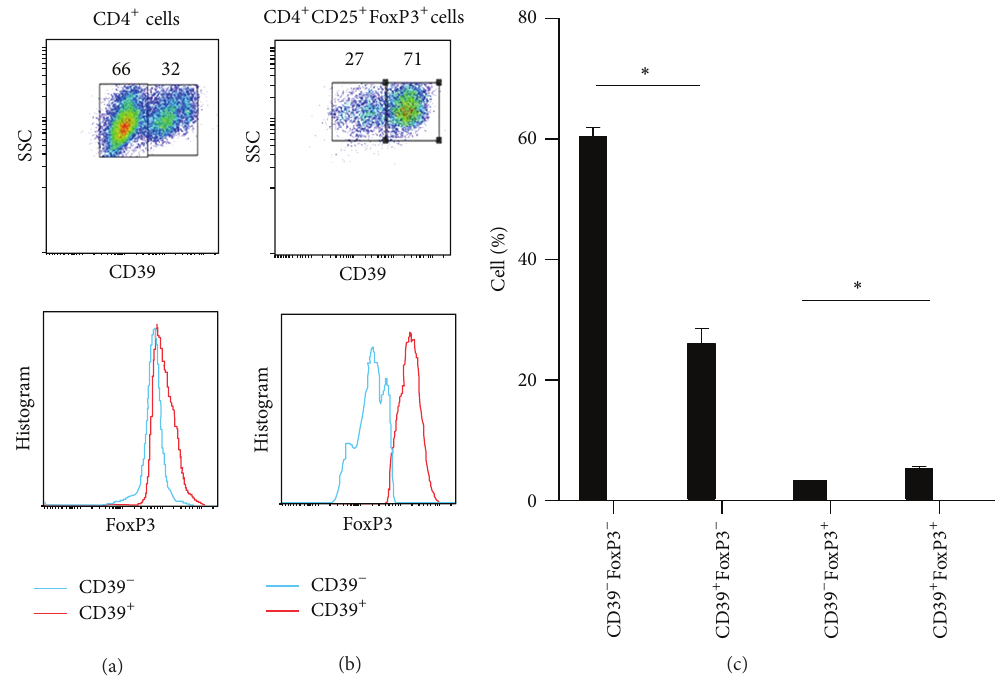
Figure 1: CD39 expression in human peripheral blood and nature FoxP3 cells. (a) Representative expression of CD39 gated in CD4 + T cells. (b) Representative expression of CD39 gated in CD4 + CD25 + FoxP3 + cells. (c) Different proportions of CD39 + and FoxP3 + cells in CD4 + T cells. The values indicated the mean ± SEM of 3 separate experiments. ∗ 𝑃 < 0.05